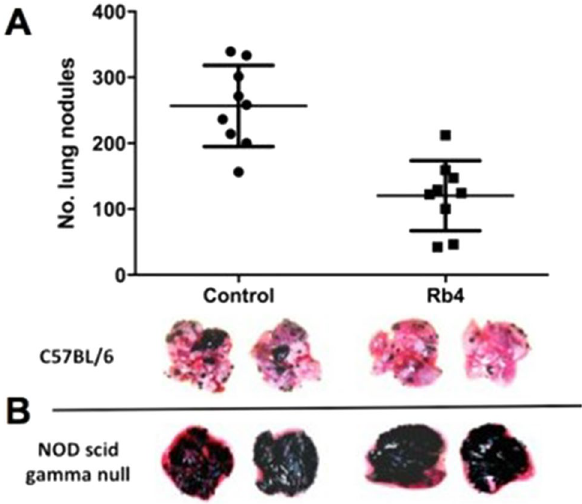
Figure 2. Effect of Rb4 on the protection against melanoma lung colonization in C57Bl/6 mice. ( A ) The graphic represents one of three independent experiments (n = 10). Two-tailed t-test (p < 0.01). Control: mice inoculated with peptide vehicle. Lack of protective effect of Rb4 against melanoma lung colonization in Nod/Scid IL-2R- gamma null (NSG) mice (n = 6). Control: NSG mice inoculated with